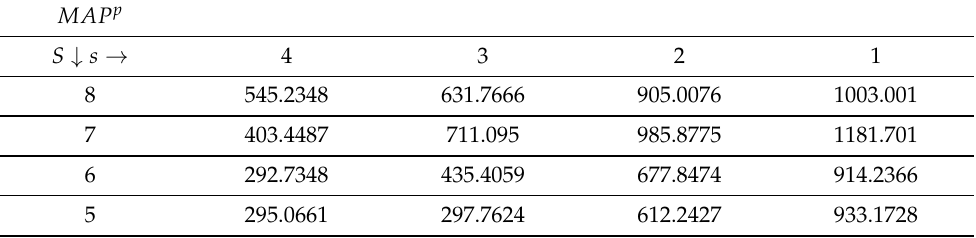
Table 8. Effect of ( s , S ) with MAP n on the Cost function: Fix S 1 = 2, S 2 = 2, s 1